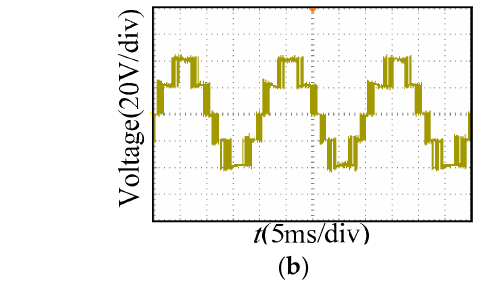
Figure 9. ( a ) Voltage for phase A. ( b ) Voltage for phase B.